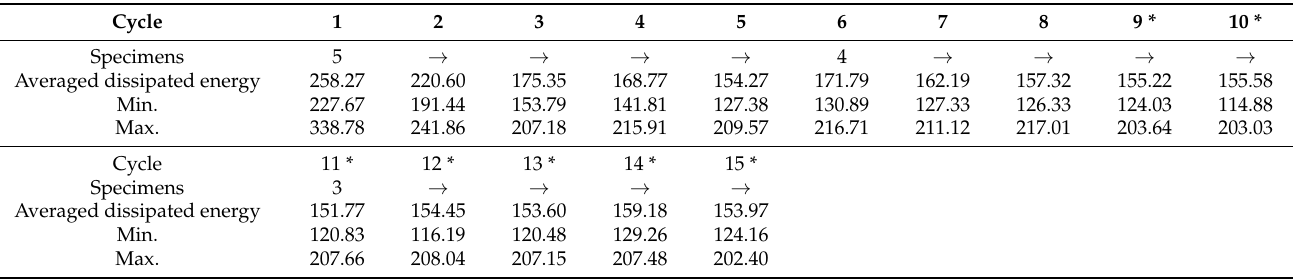
Table A4. Averaged energy dissipation per cycle (five cycles of 1460 kN after 5-785 kN and 5-1010 kN and 5-1235 kN cycles) (unit = kN ·